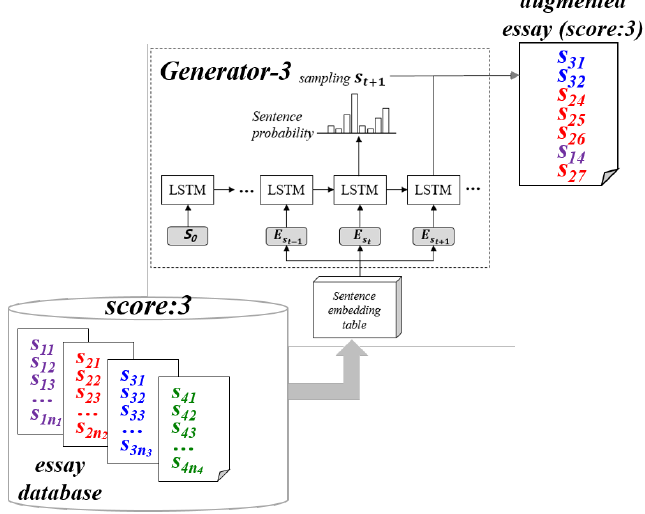
Figure 4. An example of an augmented essay, showing the number of source essays and the number of sentences in reversed